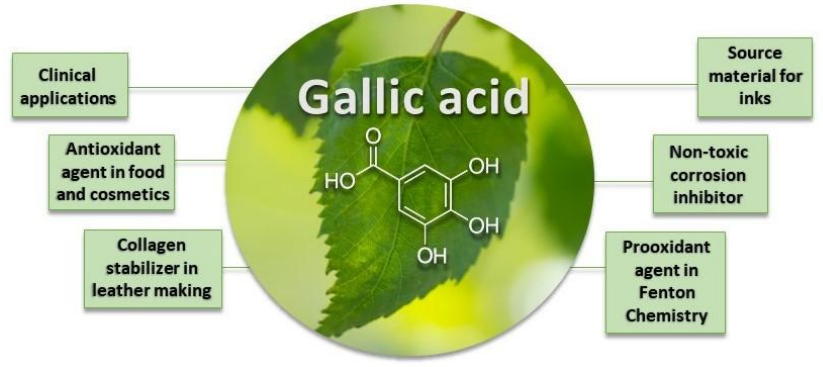
Figure 1. Different applications for gallic acid.